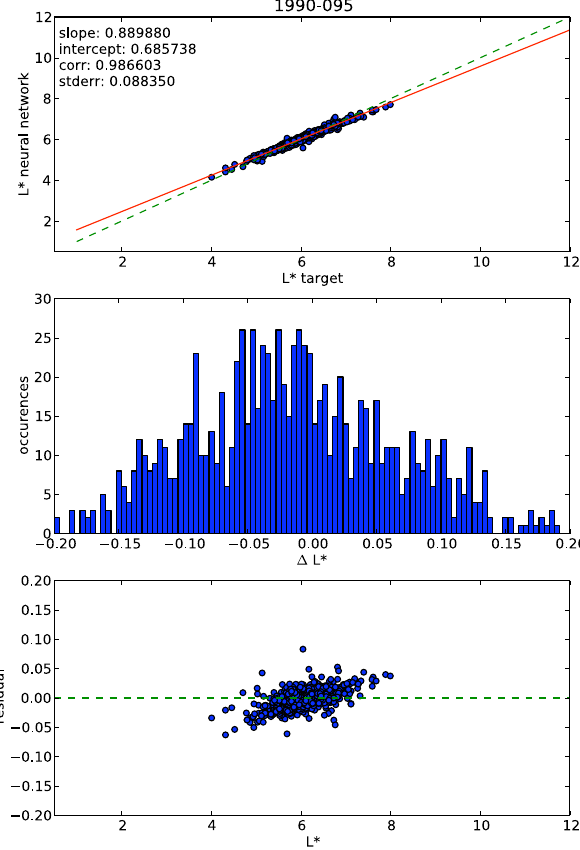
Fig. 1. Validation of neural network with LANL geosynchronous satellite 1990-095 ephemerides. Top: scatter plot of L ∗ values from model (target) against neural network results. Green-dashed line indicates a perfect fit and red solid line indicates the least-square fit to the scatter plot. One thousand ephemeris points and solar wind conditions were randomly chosen between 15 October 2001 and 30 June 2005. Middle: histogram plot of overall residuals from scatter plot. Bottom: residual plot as a function of L ∗